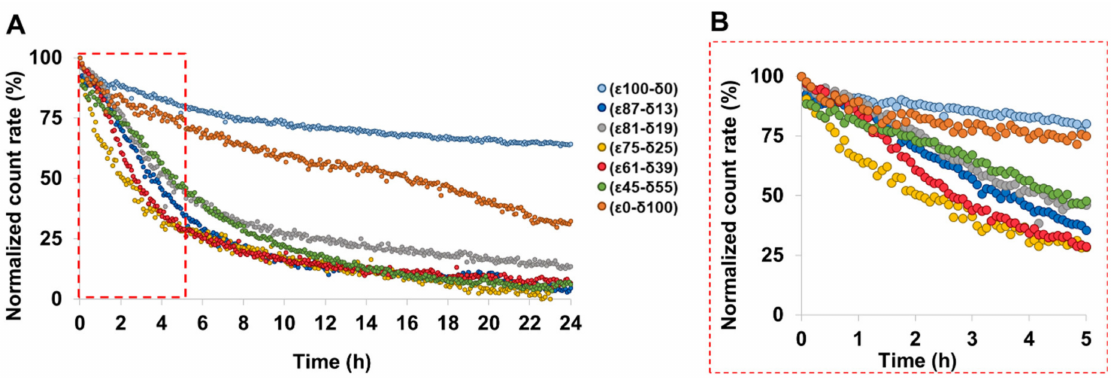
Figure 3. Normalized count rate of BRP-187-loaded PCL NPs incubated with Candida rugosa as measured by DLS for 24 h ( A ). ( B ) depicts a zoomed-in area into the data until 5